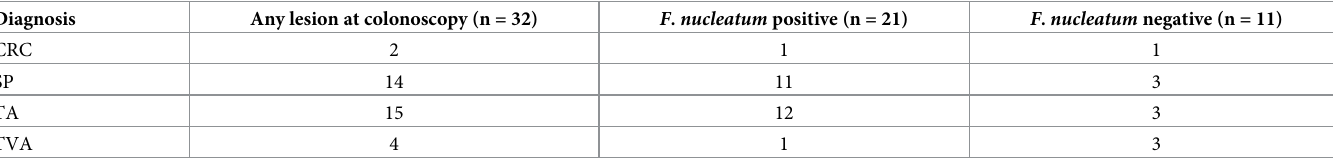
Table 2. Association of stool-associated F . nucleatum DNA with clinical lesions in the primary care cohort progressed for clinical investigation. Diagnosis Any lesion at colonoscopy (n =